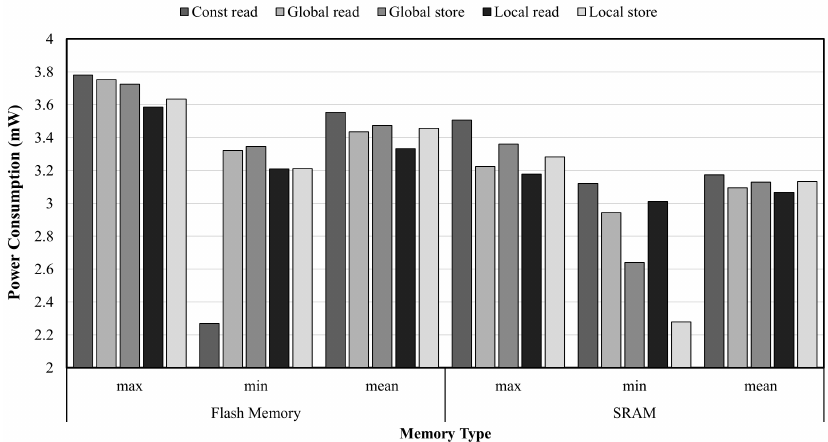
Figure 6. Additional classification of RLS